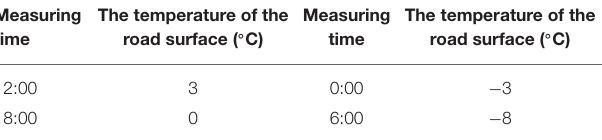
TABLE 8 | Test time and road